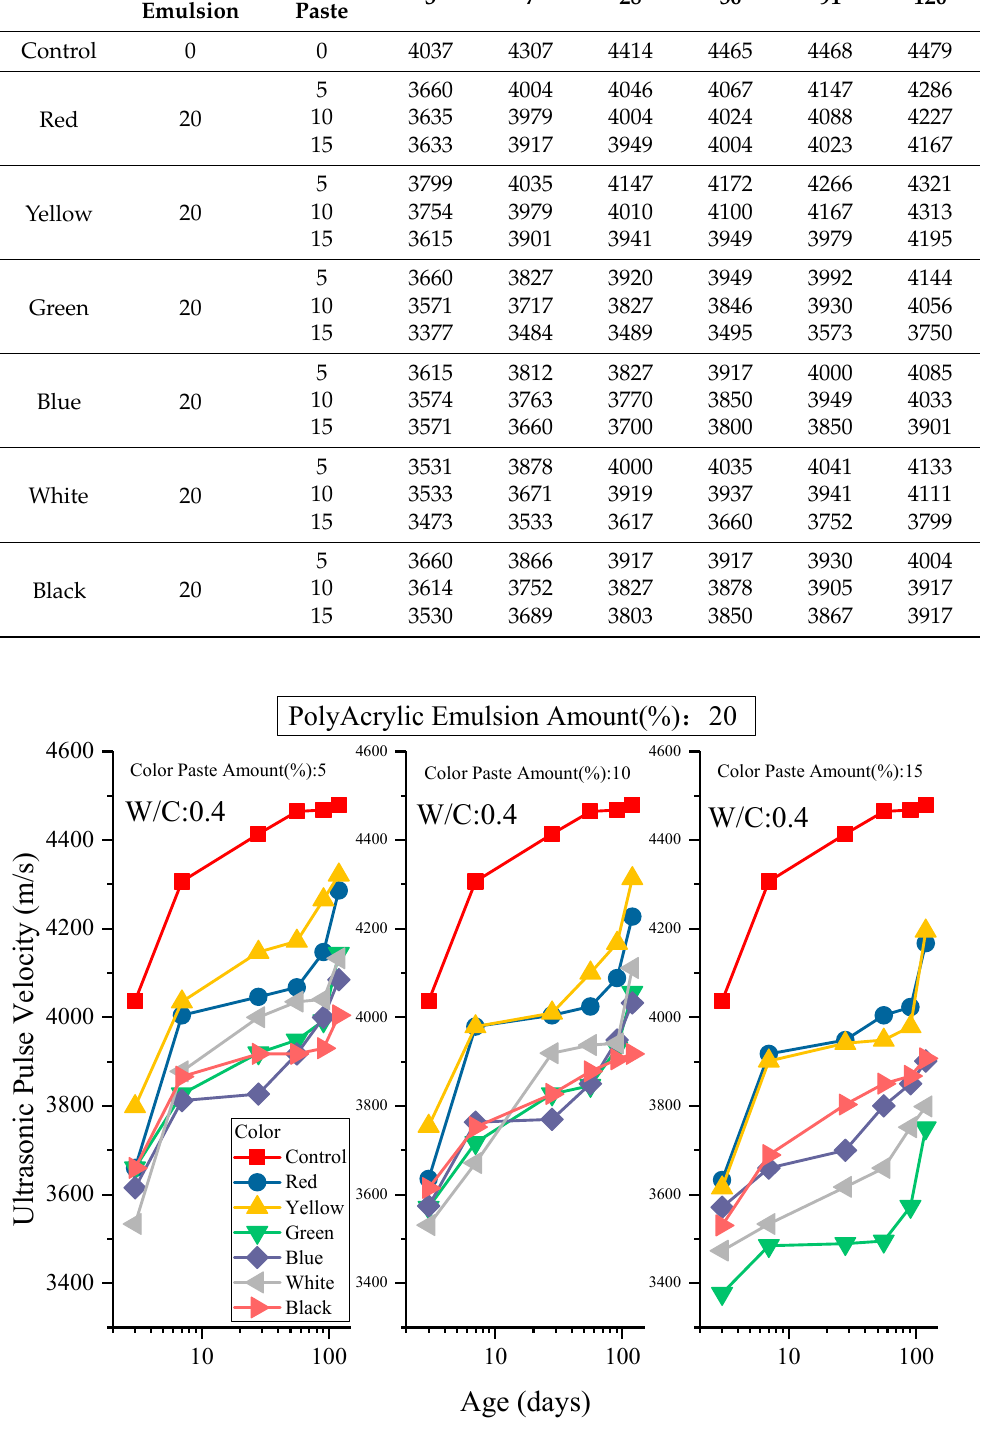
Figure 8. Ultrasonic Pluses Velocity of mortar with different proportions of Inorganic Color Paste.